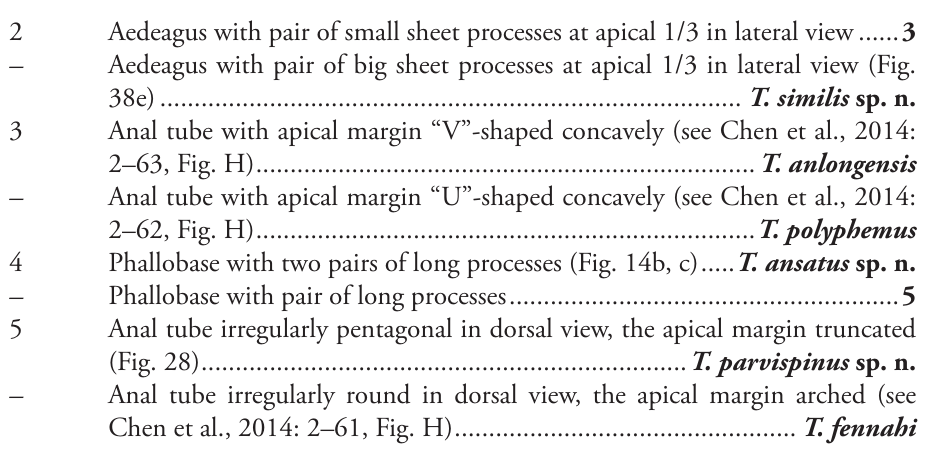
Type material. Holotype: ♂ , China: Guangxi, Nonggang (22°28'N, 106°57'E), 8 May 2012, H. Li; paratypes: 1 ♂ , Guangxi, Nonggang, 8 May, 2012, Z.-H. Fan; 1 ♀ , Guangxi, Nonggang, 6 May 2012, Z.-H. Fan. Diagnosis. This species is similar to T. polyphemus , but differs from the latter by the anal tube (Fig. 13) irregularly pentagonal in dorsal view, phallobase with two pro- cesses near basal dorsal margin (Fig. 14b, c) and aedeagus with pair of small sheet processes (Fig. 14f) at apical 1/3 in lateral view . Description. Body length: male 6.5–6.6 mm, female 6.7 mm; Forewing: male Coloration. General color brown, with irregular black mottling. Vertex with black speckles near base (Fig. 7). Eyes brown to black (Fig. 8). Frons (Fig. 9) with small black protuberance with light median line running from the upper margin, with narrow pale transverse clearer band under the black protuberance, to nearly the basal 1/3 of face, not reaching ventrally level of compound eyes, and pale spots near lateral